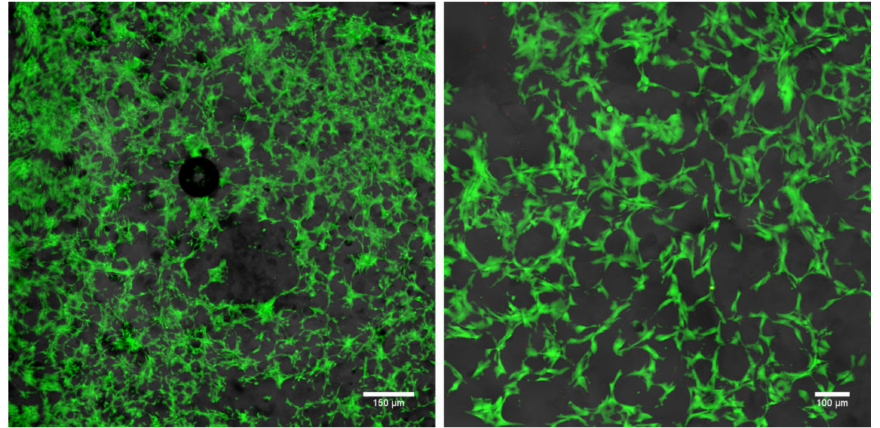
Figure 8. Confocal laser scanning microscope (CLSM) images presenting live/dead staining of BJ cells cultured on the chitosan/1,3- β - D -glucan film for 48 h (live cells—green fluorescence, dead cells—red fluorescence, Nomarski contrast was used to show the structure of films; magn. 40 × , scale bar = 150 µ m; magn. 100 × , scale bar = 100 µ